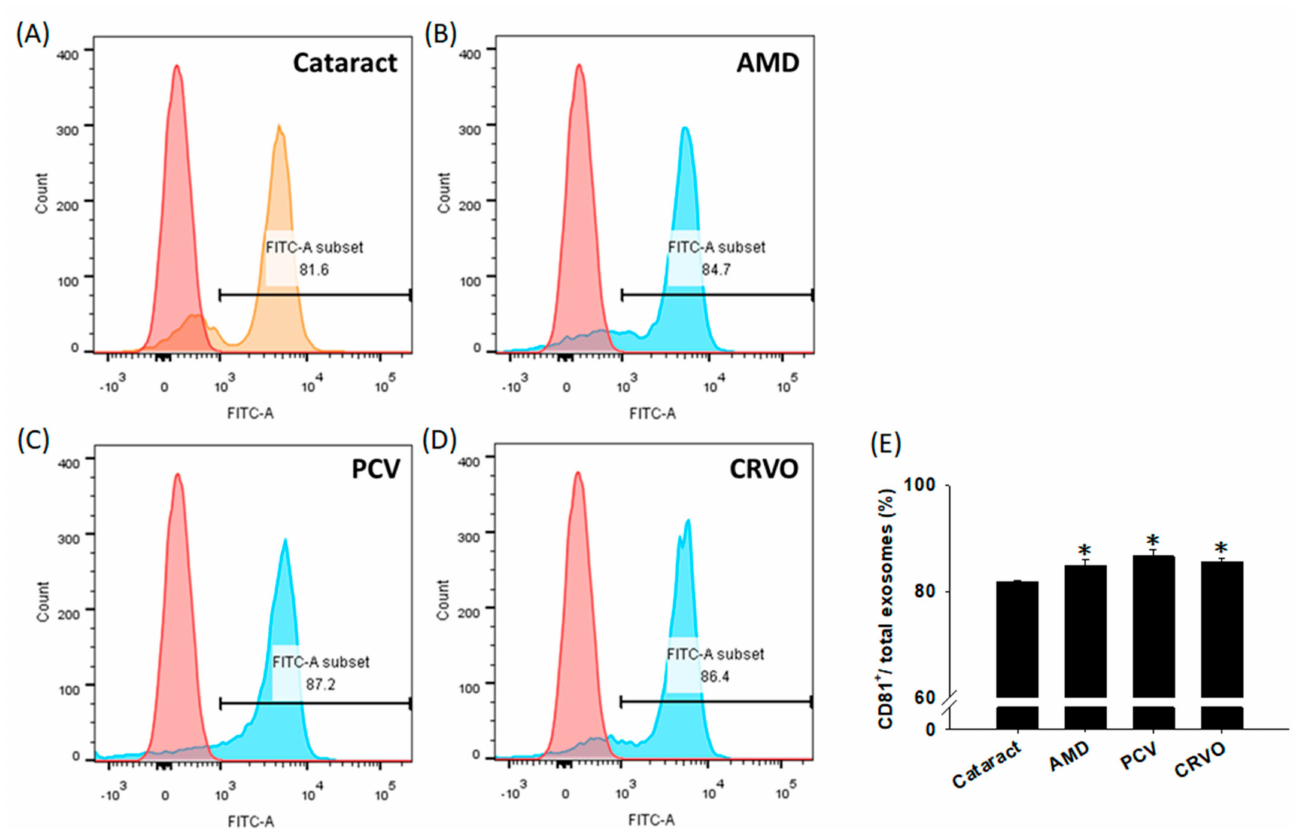
Figure 6. The percentages of CD81 + exosomes in ocular diseases. Exosomes were isolated from the aqueous humor (AH) of the patients with cataracts, age-related macular degeneration (AMD), polypoidal choroidal vasculopathy (PCV), and central retinal vein occlusion (CRVO) using a commercial Exoquick kit. The harvested exosomes were stained with CD81 + antibodies and analyzed using flow cytometry. ( A – D ) Representative histograms show the percentages of CD81 + exosomes in ocular diseases. A control group (magnetic beads only and without AH samples) and AH samples from the distinct disease subgroups are shown in red and blue, respectively. ( E ) The quantified results showing the percentages of CD81 + exosomes in total exosomes. The data are expressed as the mean ± SE of 3 samples per group. * p < 0.05 compared to the cataract